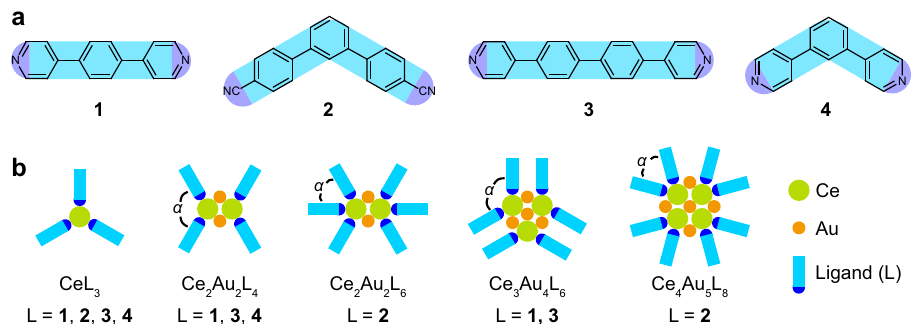
Fig. 1 Ligands used and coordination motifs achieved in this work. a Chemical structures of the molecular ligands 1 [1,4-bis(4-pyridyl)-benzene], 2 [4,4 ″ - dicyano-1,1 ′ :3 ′ ,1 ″ -terphenyl], 3 [1,4-bis(4-pyridyl)-biphenyl], and 4 [1,3-bis(4-pyridyl)-benzene] employed in this work. b Schematic illustration of the coordination motifs achieved in this work. The angles between the ligands approaching to the same Ce atom are marked by α